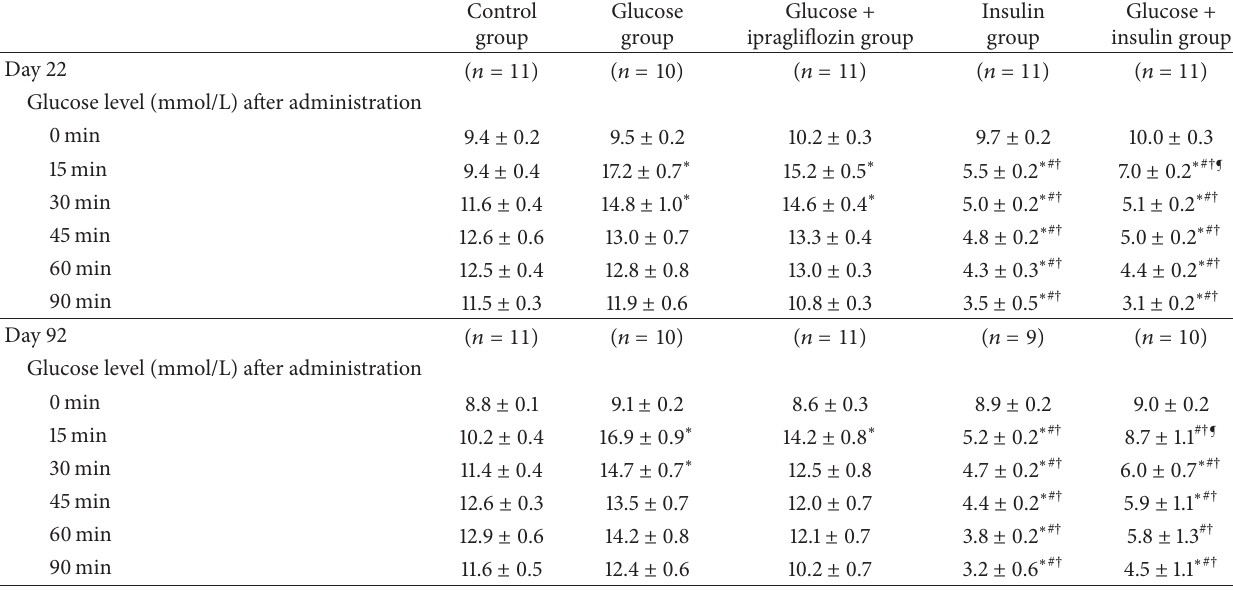
Table 4: Plasma glucose levels after intraperitoneal injection of saline or insulin in each